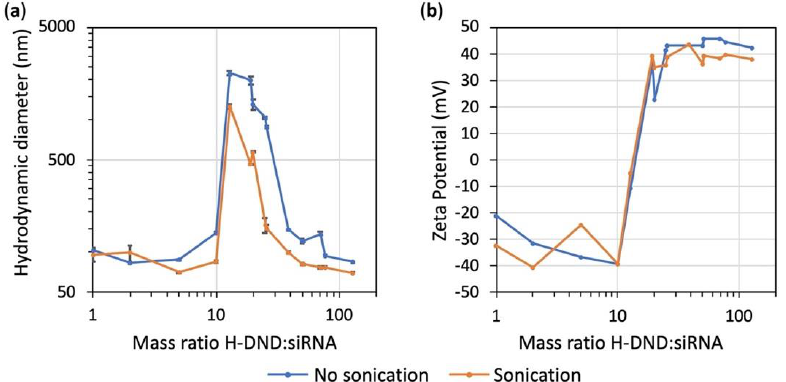
Figure 2. Variation in hydrodynamic size (in intensity) and zeta potential of siRNA bound to increasing mass ratio of H-DND (H-DND-22 sample). Complexes were prepared with or without sonication. ( a ) Size measurement by dynamic light scattering (DLS). ( b ) Zeta potential